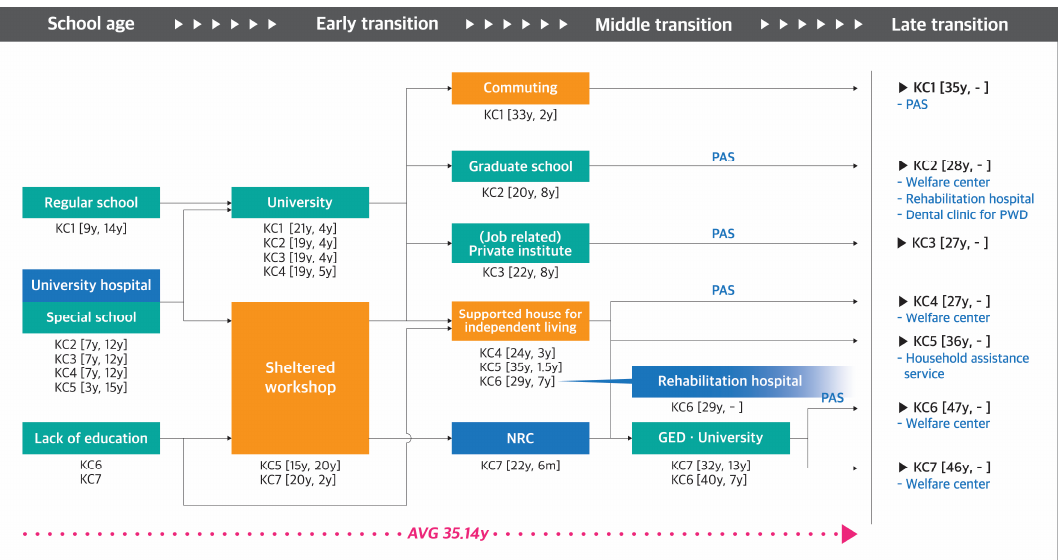
Figure 3. Pathway mapping for South Korean individuals with congenital disability. NRC, National Rehabilitation Center; GED, general equivalency diploma; PAS, personal assistance services. Note. Blue, orange, orange, green and grey color in the square respectively indicate facilities providing medical, welfare, education, and mixed medical and welfare related services. Code and number indicate participant code [the time taken to begin using the facility, the period of use] (Ex. KC7 [22y, 6m]).